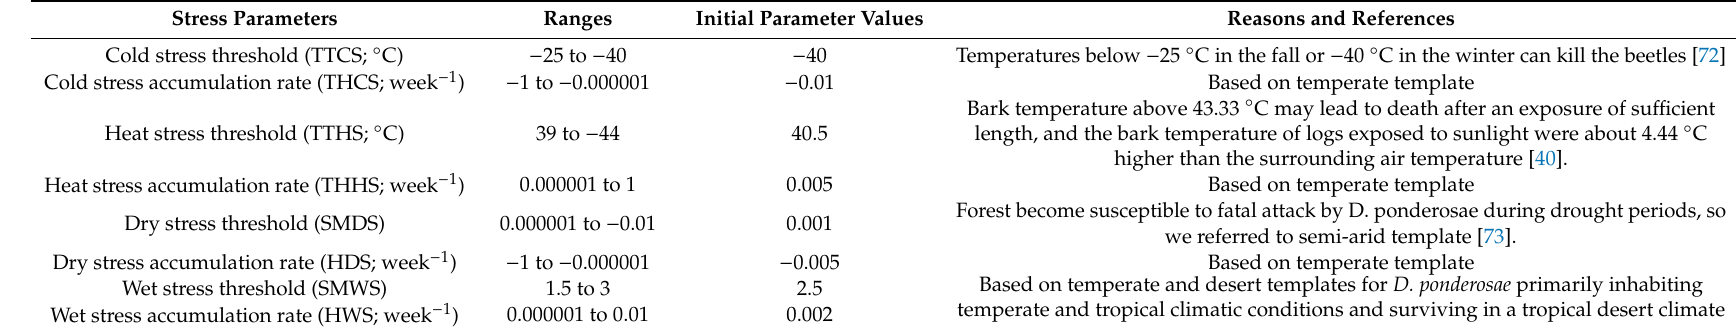
Table A1. Ranges and initial values for parameters included in the semi-automatic parameter fitting procedure.